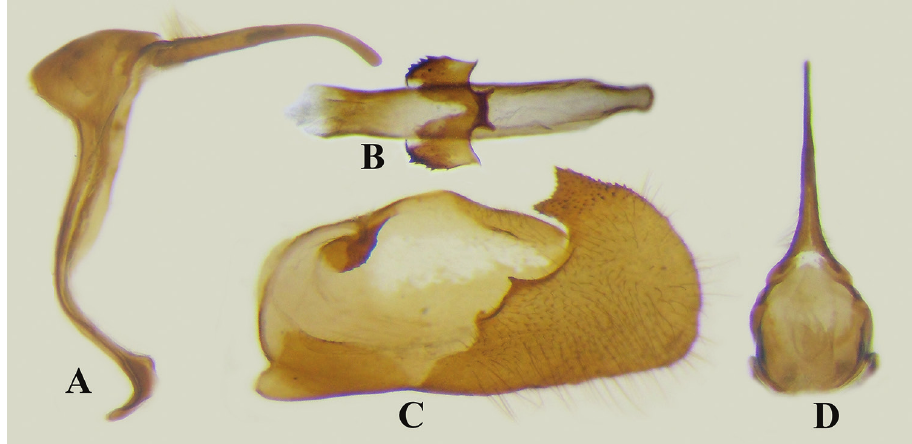
Figure 4. Male genitalia of Scobura masutaroi Sugiyama, 1996. (Sichuan). A Genitalia ring, lateral view; B aedeagus and juxta. C valva, inner view; D tegument, dorsal view.